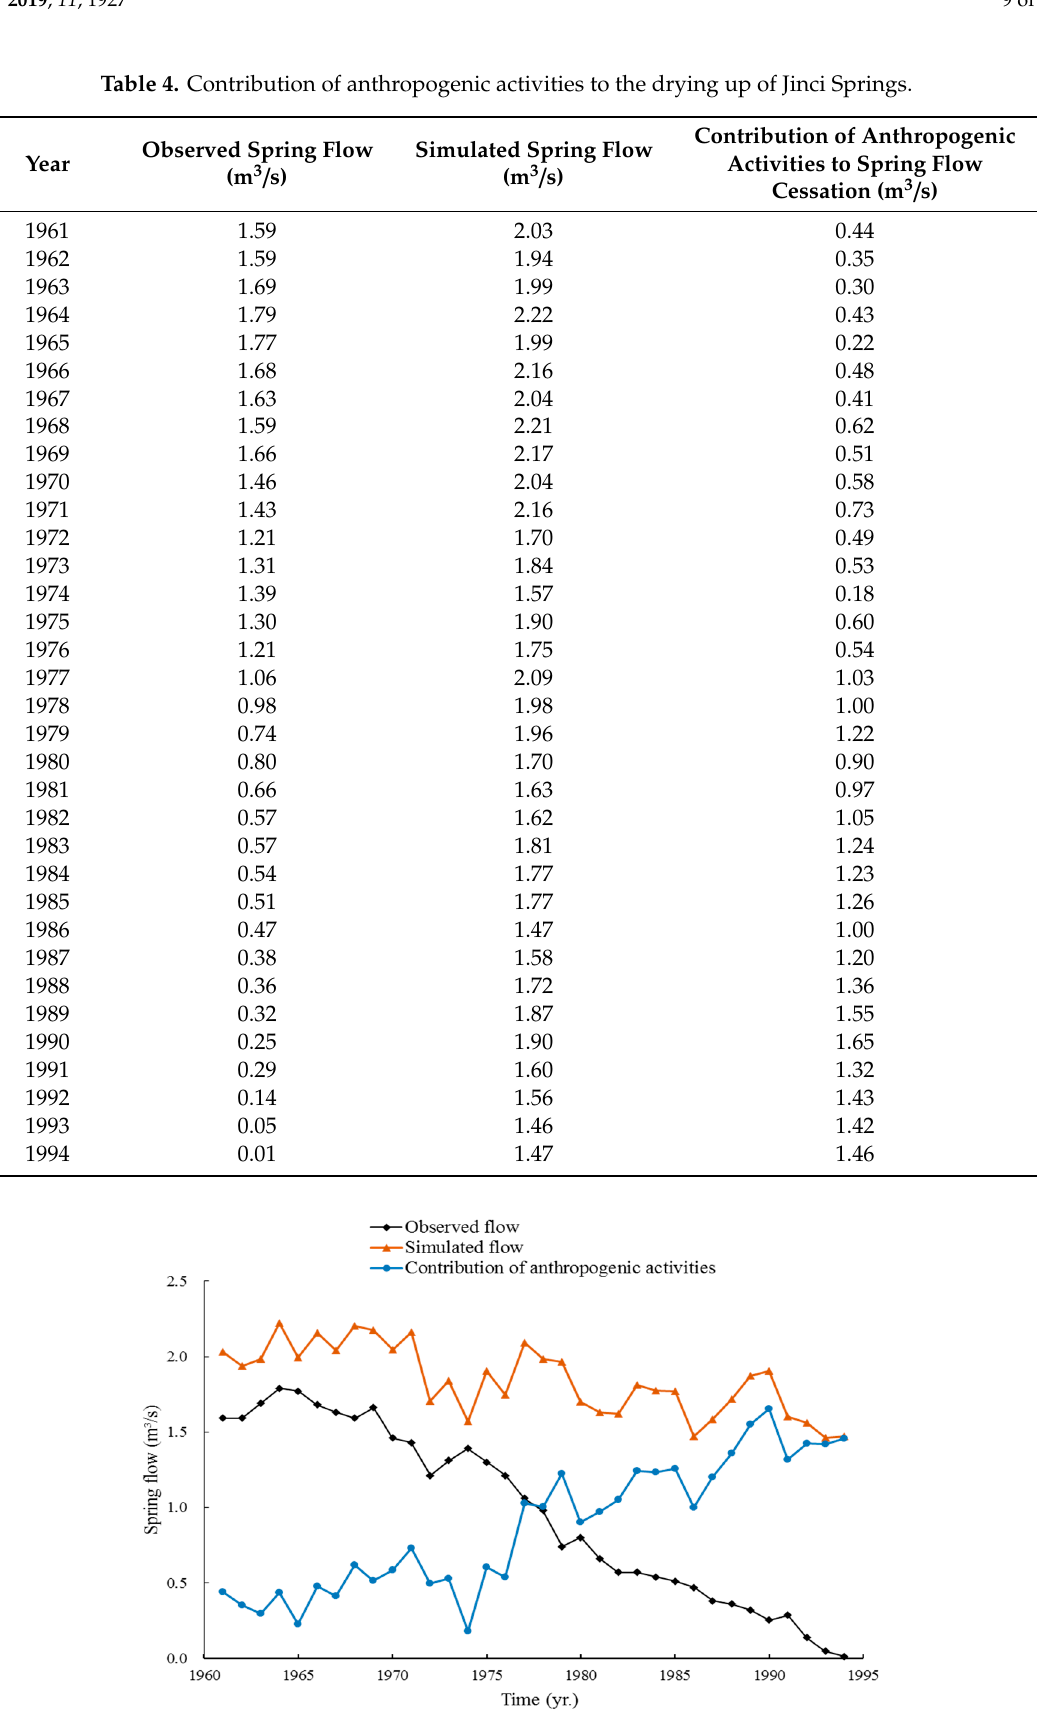
Figure 4. Contribution of anthropogenic activities to spring flow attenuation in Jinci Springs.